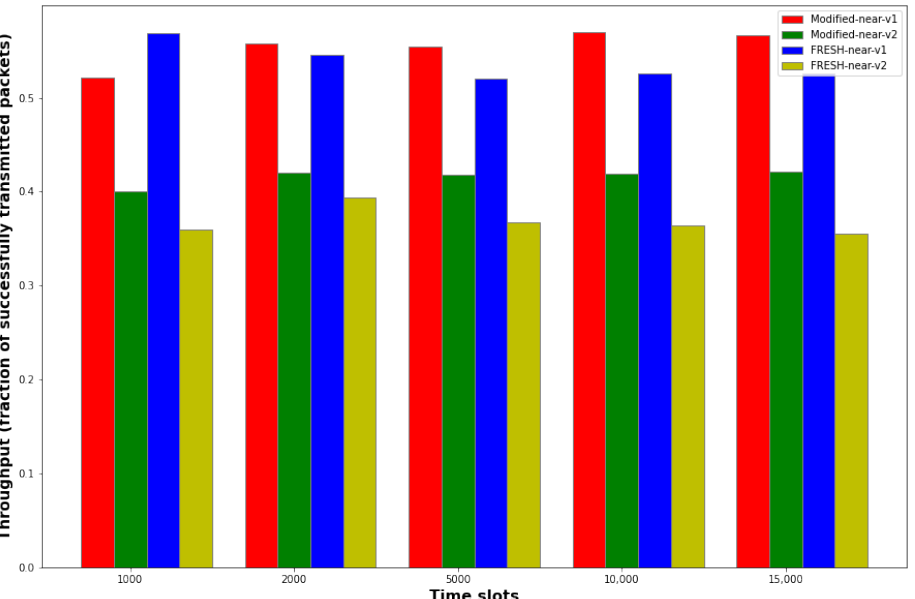
Figure 5. Dependence of throughput versus number of time slots for Modified-near-v1, Modified- near-v2, FRESH-near-v1 and FRESH-near-v2